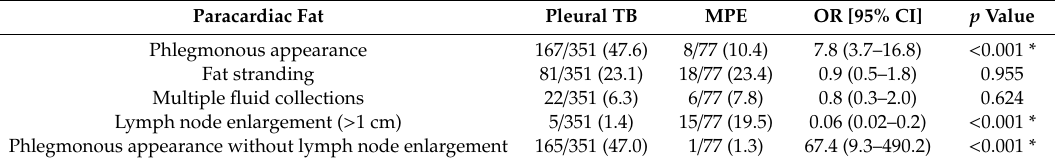
Table 2. Prevalence of phlegmonous appearance, fat stranding, multiple fluid collections, and lymph node enlargement in the ipsilateral paracardiac fat in patients with pleural TB and those with malignant pleural e ff